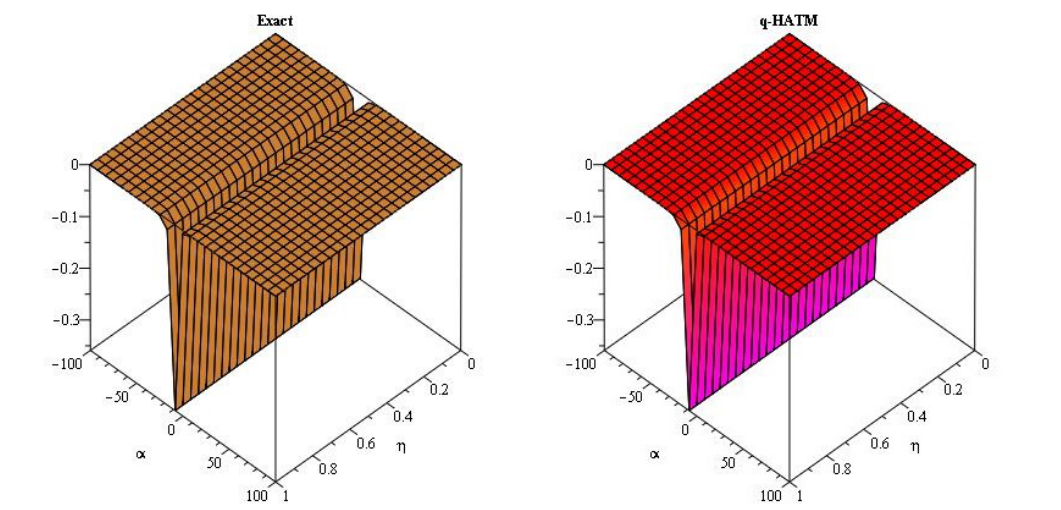
Figure 11. Exact and q-HATM solution of ν ( α , η ) at δ =